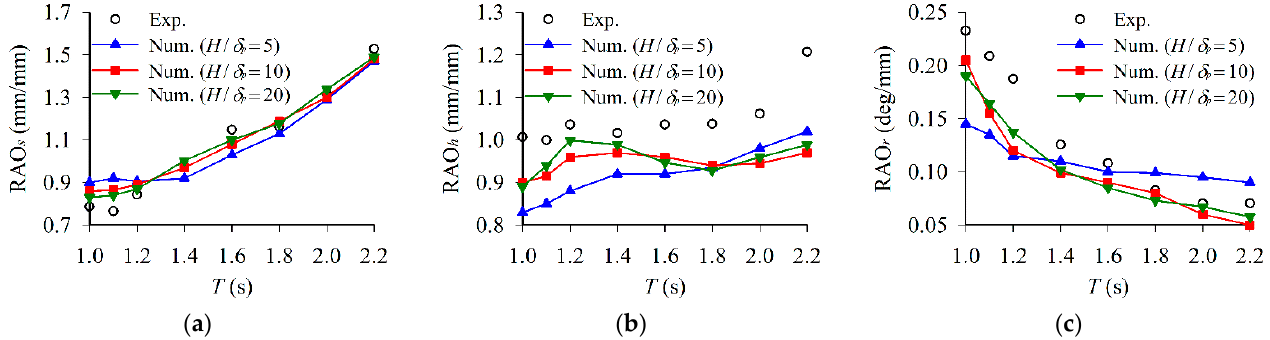
Figure 6. Comparison of the experimental and numerical response amplitude operators of the cuboid floating pontoon: